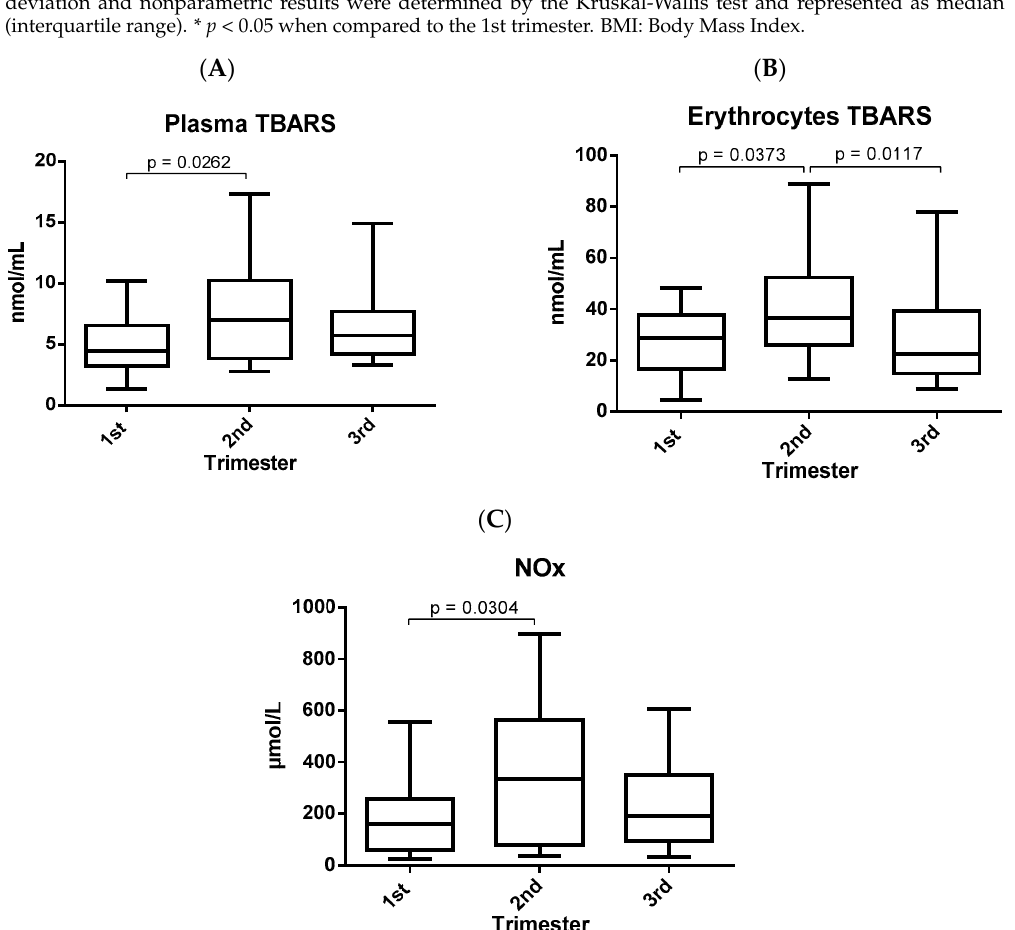
Figure 2. Markers of oxidative damage in the three gestational trimesters. Data are presented as median with interquartile range. Statistically significant differences were determined by Kruskal-Wallis. ( A ) TBARS levels in plasma; ( B ) TBARS levels in erythrocytes; ( C ) dosage of nitric oxide; TBARS: thiobarbituric acid-reactive substances; NOx: nitric oxide.